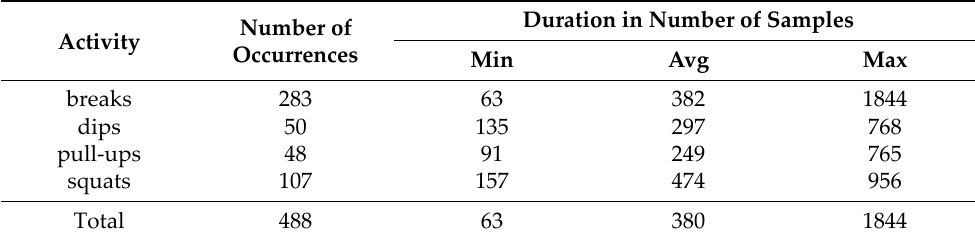
Table 3. The number of activity occurrences and the statistics of duration.